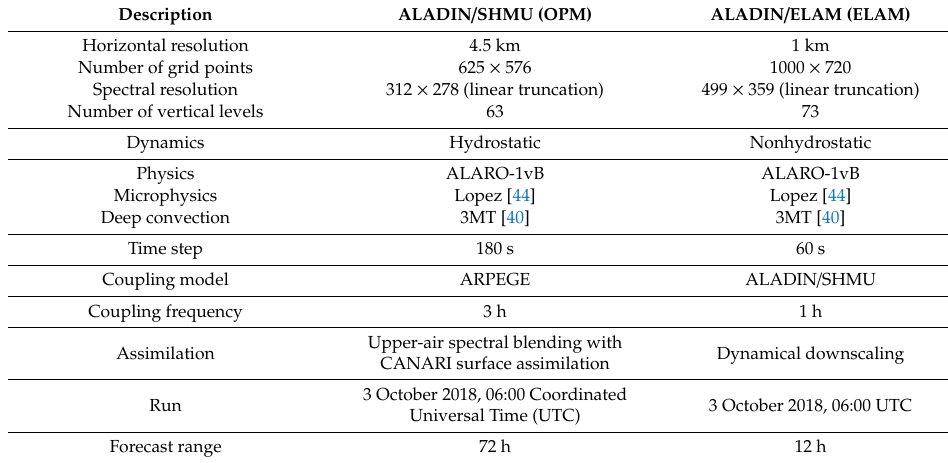
Table 1. Description of numerical weather prediction (NWP) operational model Aire Limitée Adaptation Dynamique Développement InterNational (ALADIN) of the Slovenský Hydrometeorologický Ústav (SHMU) (OPM) and ALADIN Experimental Local-Area Model